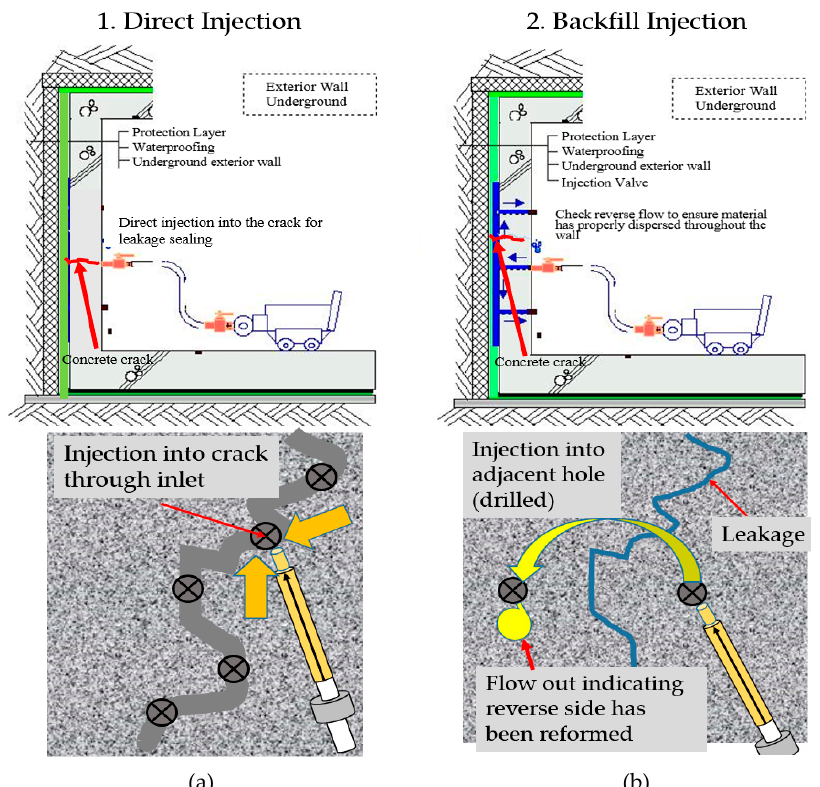
Figure 3. Grout injection in a below-grade concrete structure for the repair of a waterproofing layer: ( a ) the direct injection method and ( b ) the backfill injection method. ( a ) the direct injection method and ( b ) the backfill injection